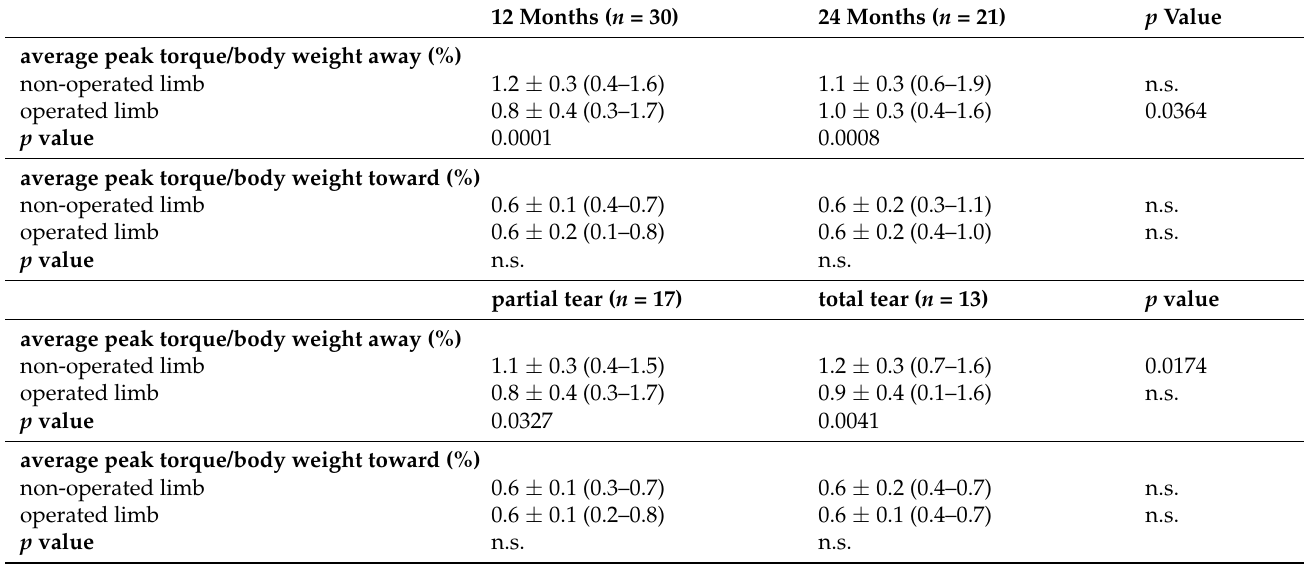
Table 5. The isometric outcomes of the surgical